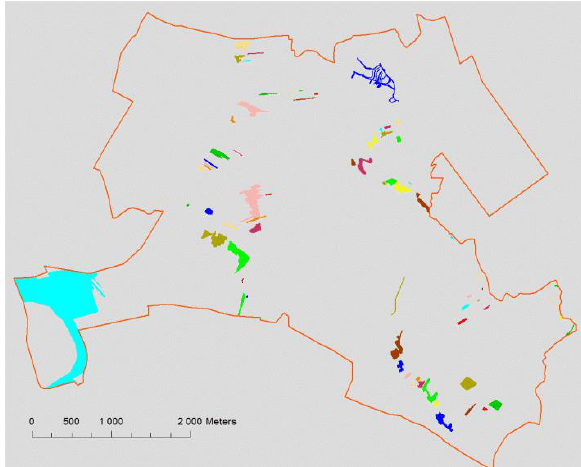
Figure 8. The results of the distance analysis of Label Objects